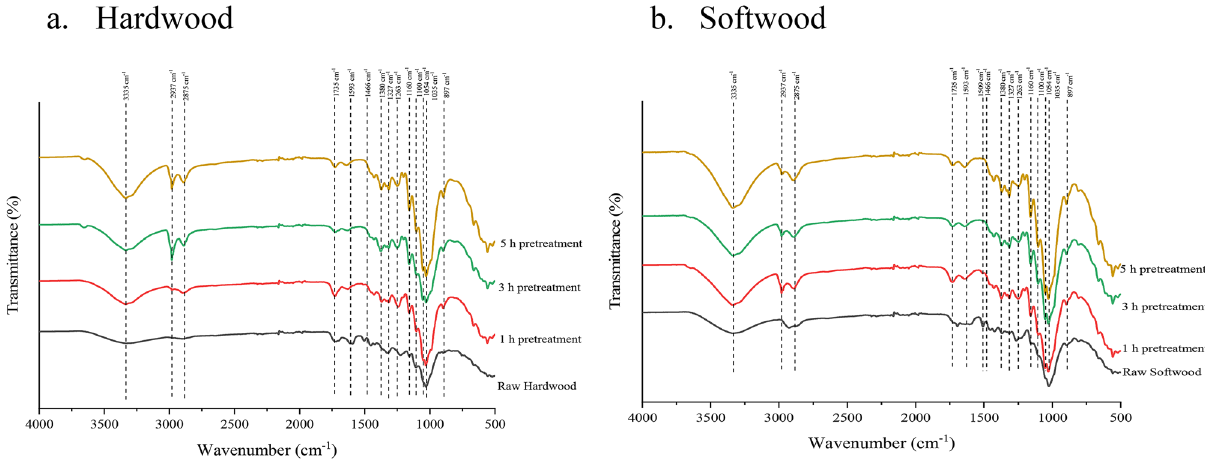
Figure 4. FTIR spectra of untreated and pretreated